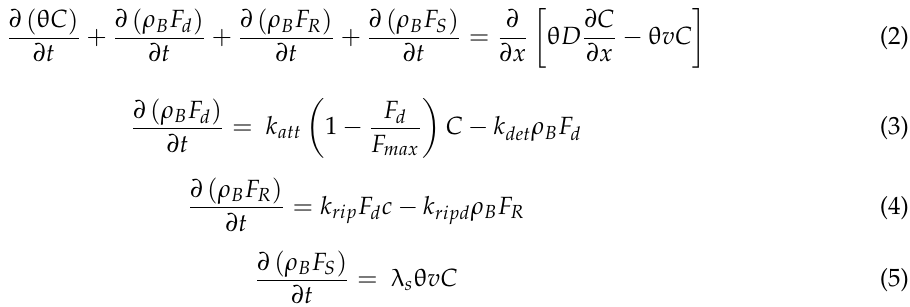
C— concentration of colloids in suspension; F d —colloid concentration on solid media; F R —the concentration of filtration and the aging process; F S —blocked colloidal solid concentration; k att —colloid deposition rate constant; k det —colloid release rate constant; k rip —the colloid filtration and ripening rate constant; λ s —colloid blocking filtration coefficient; ρ B —dry bulk density of porous media (2400 kg/m 3 ); θ —porosity of porous media; D —dispersion coefficient [14]; x —colloid migration distance; v —average velocity of